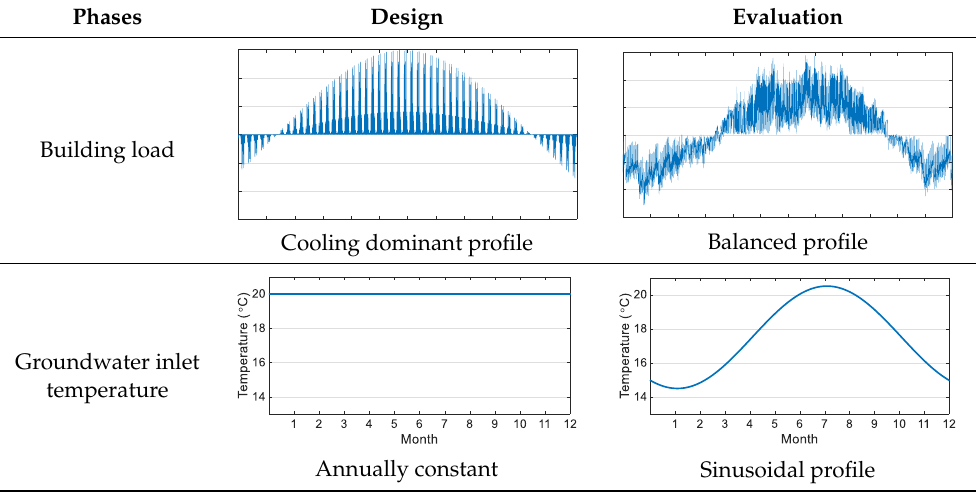
Table 4. Different simulation conditions for PDHP system design and performance estimation.